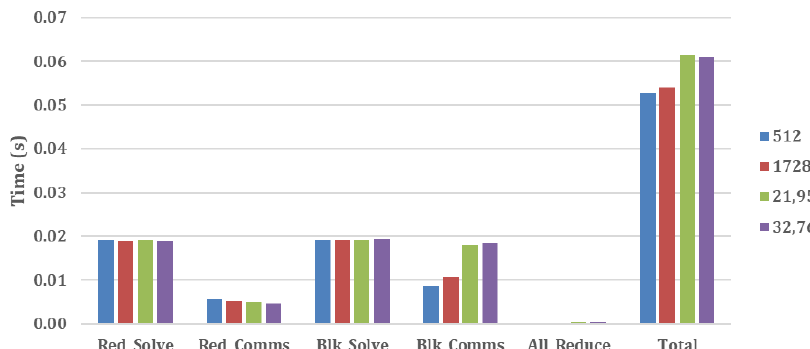
Figure 6: INTv2 Performance for Various Processor Counts at R/B-16